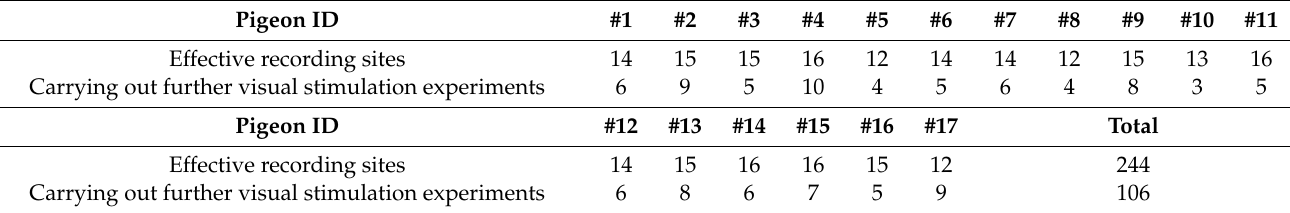
Table 1. The number of effective recording sites and sites for the analysis of each pigeon.